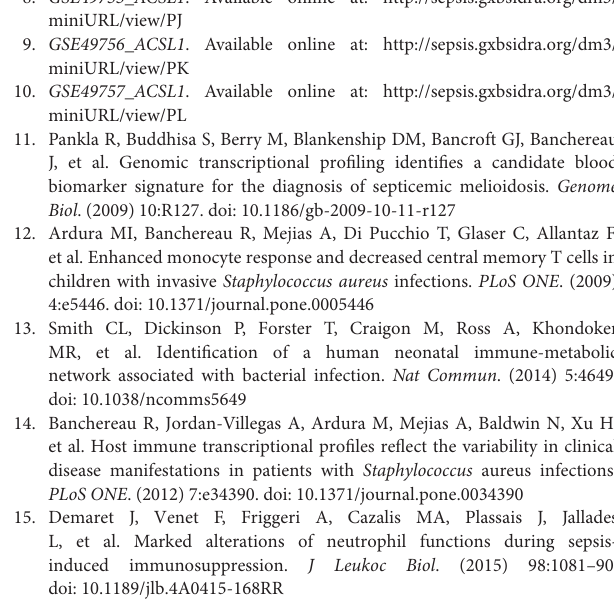
Supplementary Figure 1 | Tissue restriction of ACSL family members. Relative abundance levels of the 5 members of the ACSL family across 8 different human tissues is shown is this figure. Expression data used to generate the plots were obtained from the BioGPS dataset (21). Each family member is represented by a different color: ACSL1 (red), ACSL2 (beige), ACSL4 (green), ACSL5 (blue), and ACSL6 (purple). Predominance of a given color in a circle denotes predominance of expression of the corresponding ACSL family member in the tissue in question. Cord plots were generated using the circlize R package (121). Supplementary Figure 2 | Abundance levels of a co-expressed geneset comprising ACSL1 across leukocyte populations and disease states. A reference public domain dataset was downloaded from GEO (GSE60424) in which RNAseq profiles were generated for 6 leukocyte subsets (legend: cell types) isolated from 20 blood samples collected from healthy subjects and subjects with a wide range of pathologies (legend: disease). Z-scores were computed from normalized counts and displayed on a heatmap (blue/gray = low expression; yellow = high expression. Samples were arranged according to grouping information and genes were arranged based on similarities in patterns of expression across samples. Supplementary Figure 3 | Correlation matrix for “inflammasome” and “fatty acid metabolism” gene sets. Lists of genes known to be associated with inflammasome and fatty acid metabolism were derived from targeted RT-PCR panels (referenced in the text). ACSL1 was added to the inflammasome list. The matrix represents degree of correlation calculated for each gene pair using the septic plasma neutrophil exposure dataset